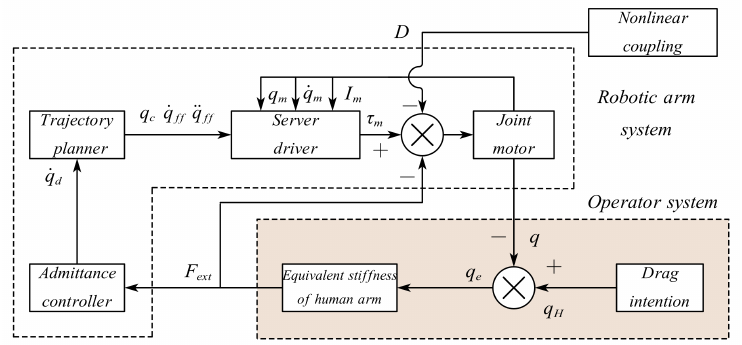
Figure 7. Human–computer interaction admittance control